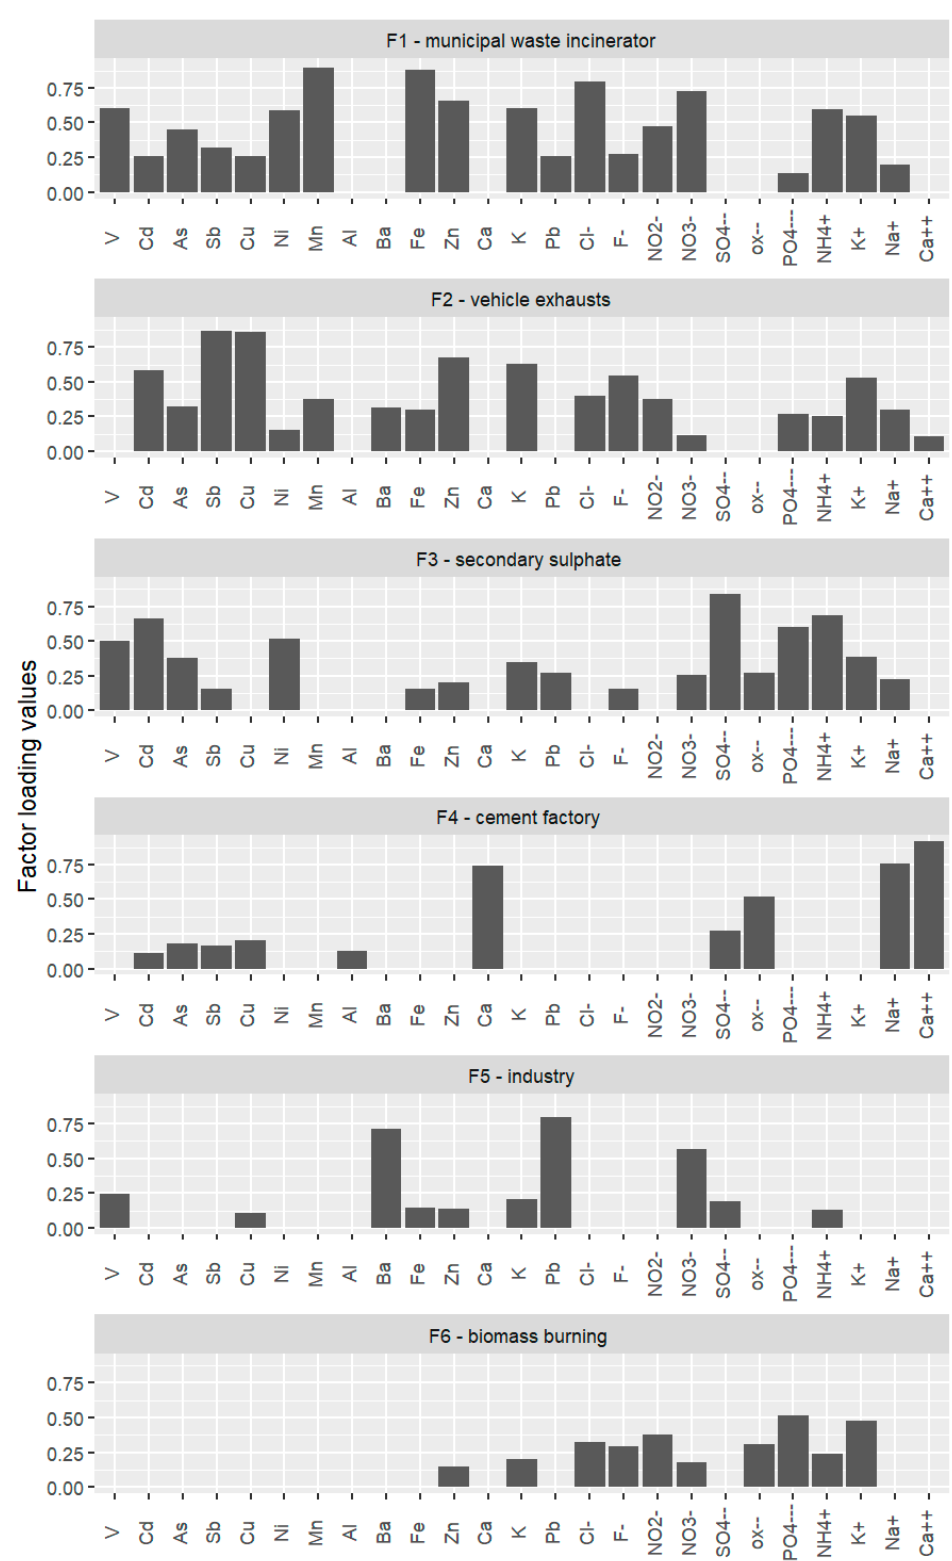
Figure 7. Source profiles for PM 1 in Brno.